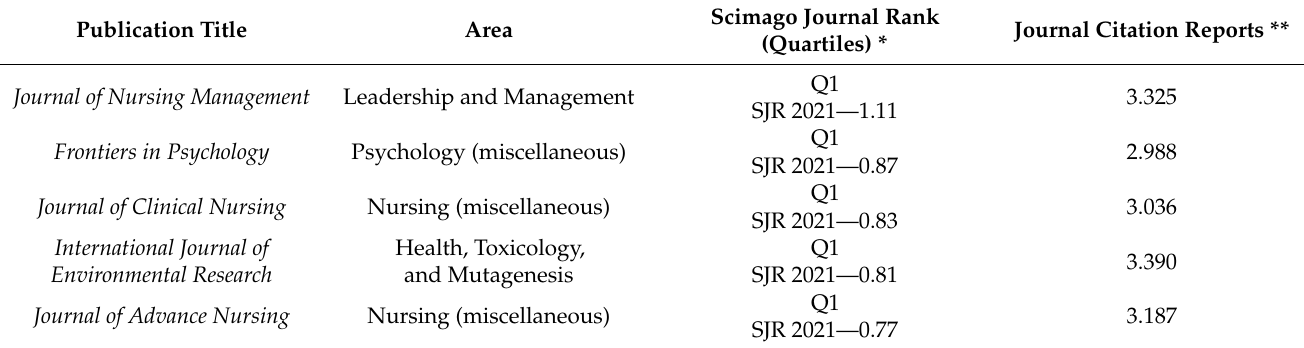
Table 1. Top 5 Journals with highest impact factor.